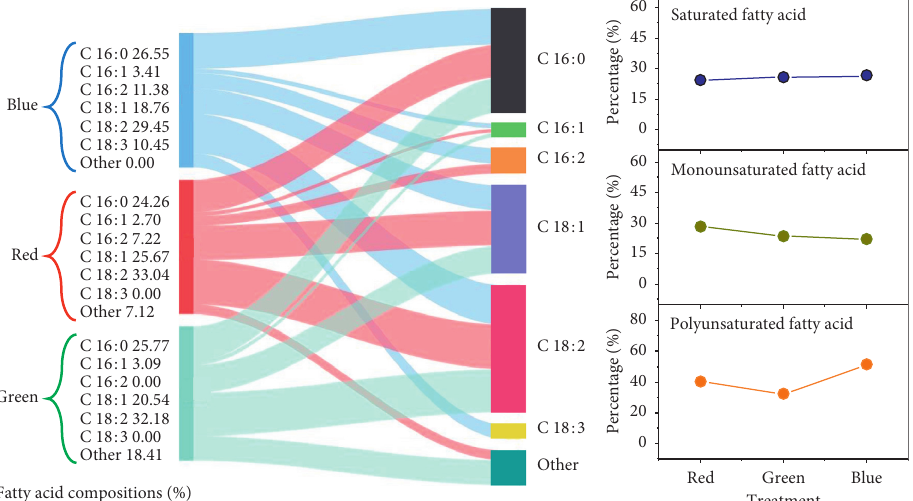
Figure 4: Fatty acid compositions of Golenkinia SDEC − 16 cultivated under red, green and blue